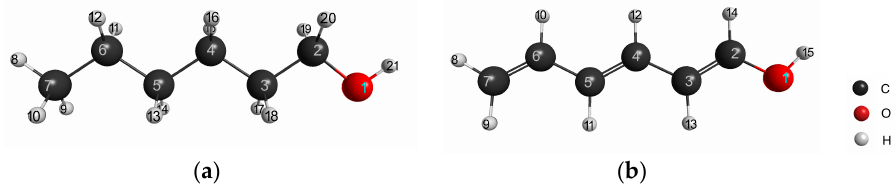
Figure 5. Geometries of ( a ) hexan-1-ol and ( b ) hexa-1,3,5-trien-1-ol molecules.